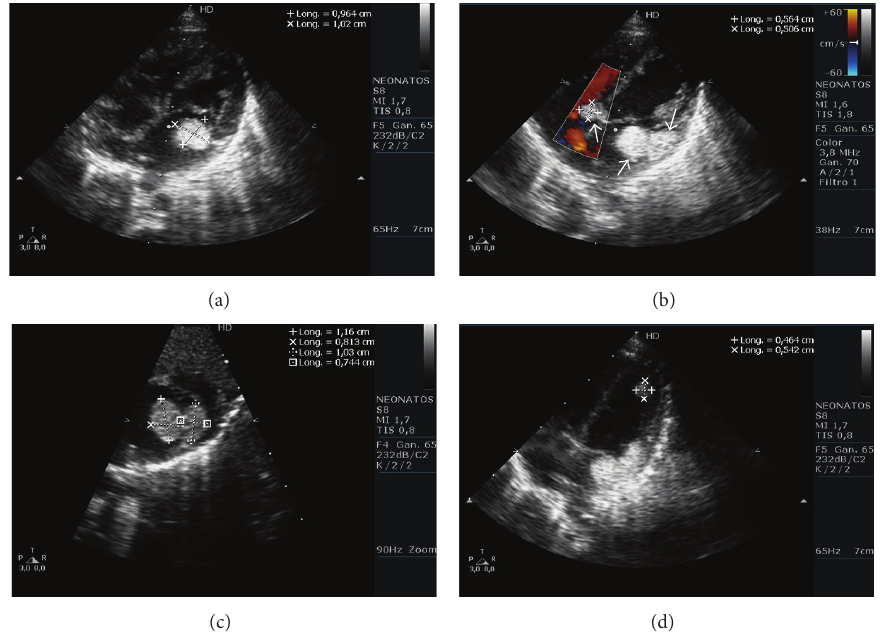
Figure 1: Views of different sizes and localisations of rhabdomyomas at the time of diagnosis. (a) Four-chamber view with intracavitary masses in mitral valve of 0,9 × 1cm. (b) Four-chamber doppler-colour view of intracavitary mass of 0,5 × 0,5 cm in tricuspid valve, one intracavitary mass in mitral valve and one intraparietal mass in lateral wall of left atrium (arrows). (c) Subcostal view of left ventricule. One intracavitary mass and one intraparietal mass in lateral face of left ventricule. (d) Four-chamber view of intraparietal tumour in left ventricule